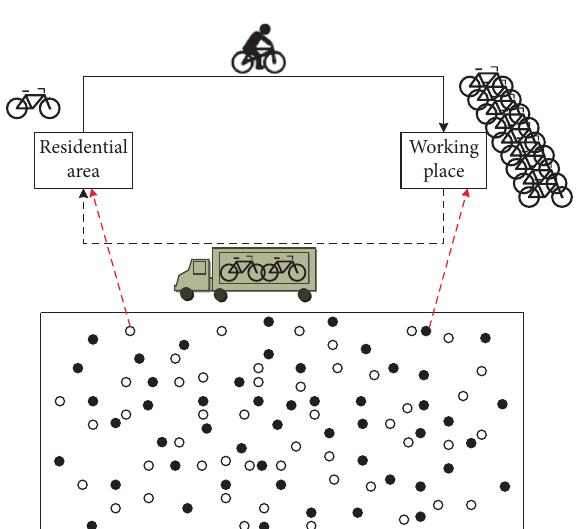
Figure 2: The mismatch phenomenon of a BSS during the morning peak. Black circles represent stations with excessive bikes, while white circles represent stations with insufficient